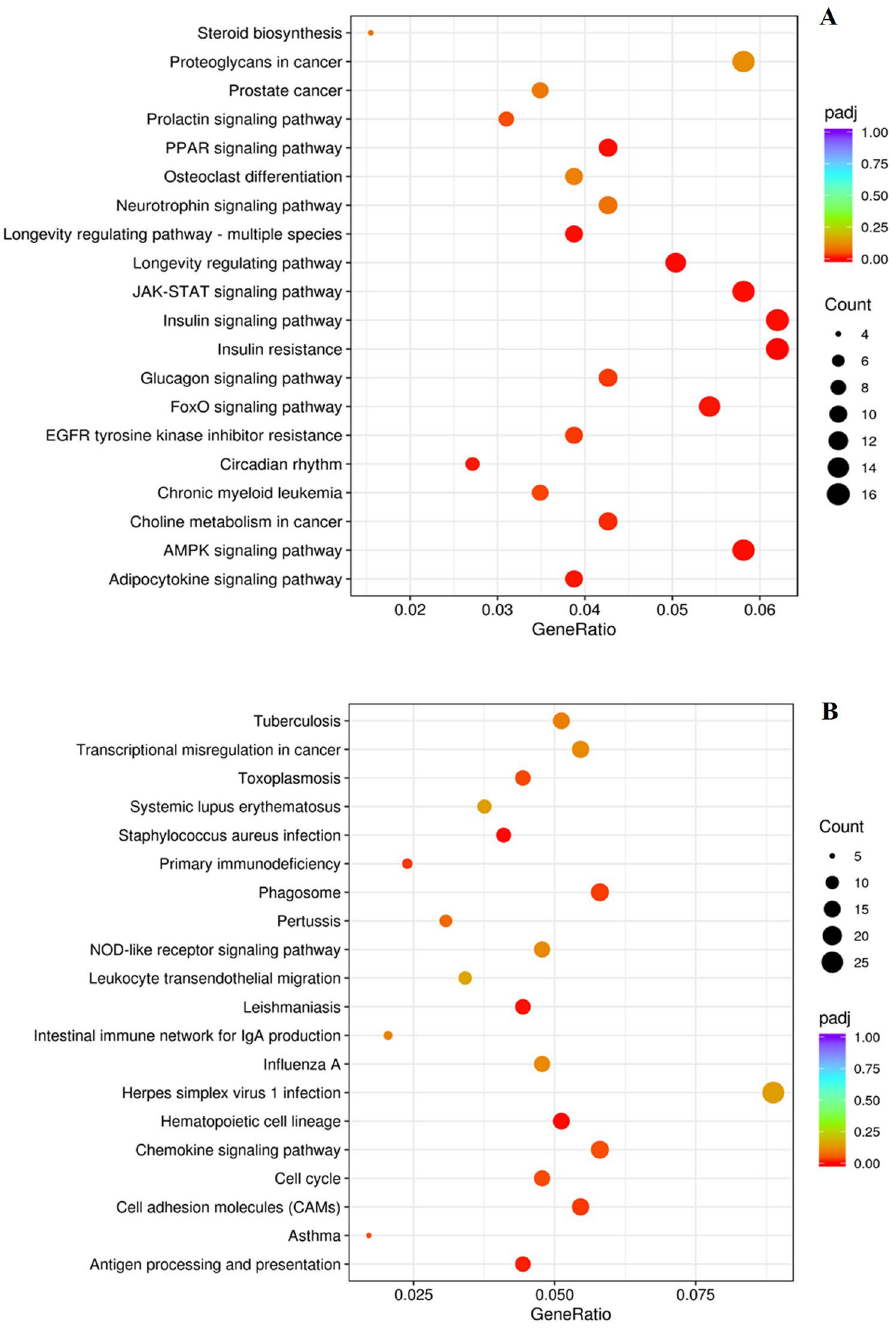
Figure 8. ( A ) Upregulated and ( B ) downregulated KEGG pathways in meat ( Longissimus dorsi ) samples after 6 days, from goats subjected to control (not transported but held in pens) vs.30 min (transported for 30 min) stress